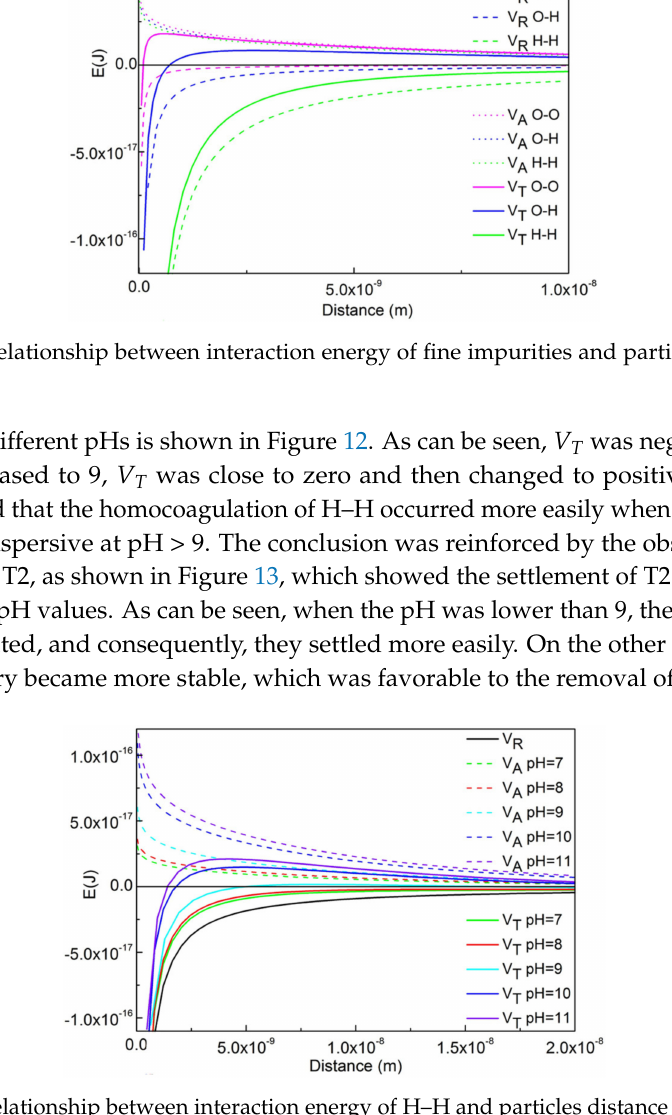
Figure 12. The relationship between interaction energy of H–H and particles distance at different pHs.